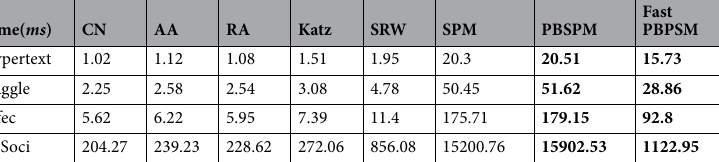
Table 2. Computation time of different methods for four networks. All the results are averaged over ten runs on AMD R7 computer with MATLAB R2016b and 8GB